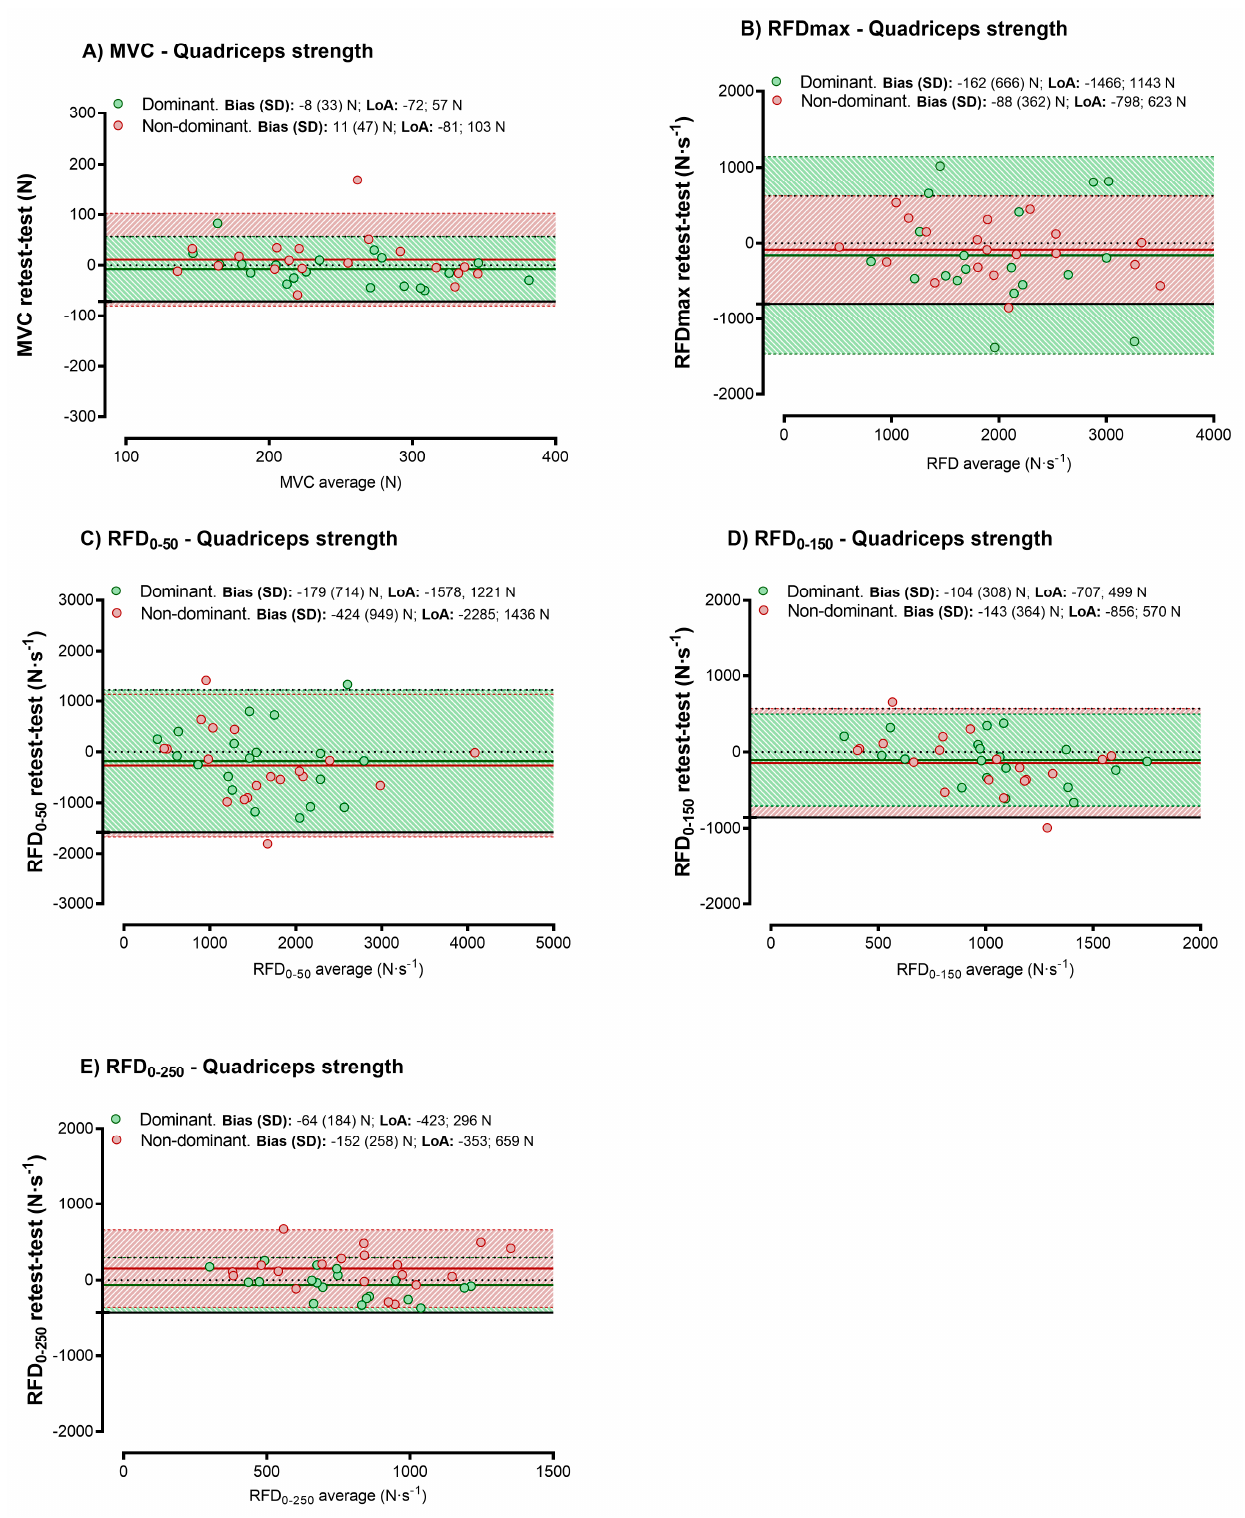
Figure 3. ( A – E ) Bland–Altman plots show the bias (test-retest differences) for the isometric quadriceps strength test. Shadows are limits of agreement (LoA) for dominant (green, clear) and non-dominant (red, dark) legs.